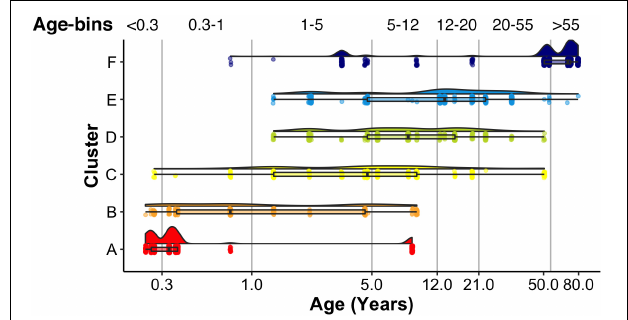
FIGURE 15 | Raincloud plot showing the distribution of sample ages by cluster. Vertical lines correspond to the bounds of pre-defined age bins. Samples corresponding to the youngest age (i.e., 20 days) are not